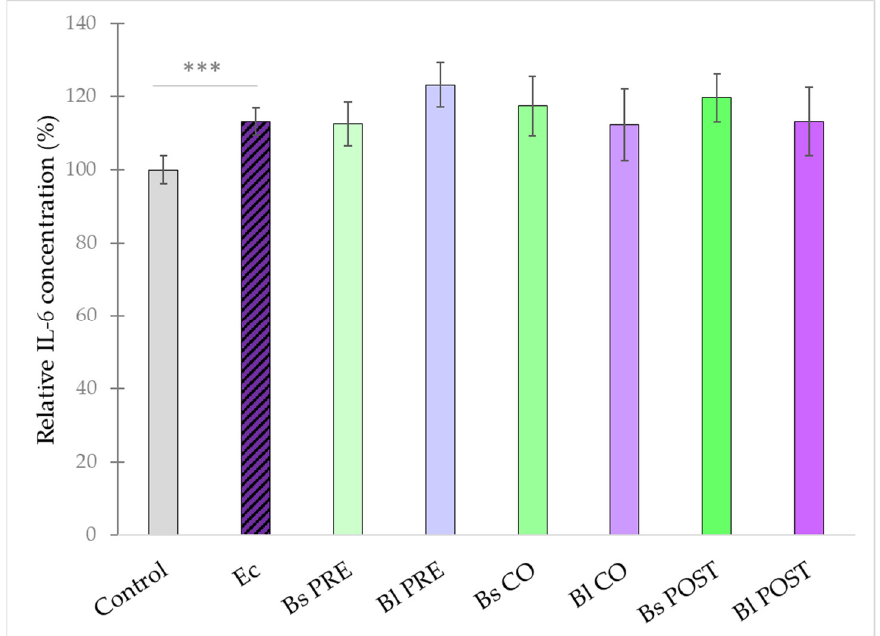
Figure 6. Induction of IL-6 secretion of IPEC-J2 cells after stimulation with E. coli , B. licheniformis, and B. subtilis . B. licheniformis and B. subtilis were added 1 h before (pre-treatment), at the same time as (co-treatment), or 1 h after (post-treatment) the addition of E. coli . B. licheniformis and B. subtilis were added in 10 8 CFU/mL and E. coli was added in 10 6 CFU/mL concentration. Control : plain cell culture medium treatment; Ec : E. coli 10 6 CFU/mL; Bs PRE : pre-treatment with B. subtilis 10 8 CFU/mL + E. coli 10 6 CFU/mL; Bl PRE : pre-treatment with B. licheniformis 10 8 CFU/mL + E. coli 10 6 CFU/mL; Bs CO : co-treatment with B. subtilis 10 8 CFU/mL + E. coli 10 6 CFU/mL; Bl CO : co-treatment with B. licheniformis 10 8 CFU/mL + E. coli 10 6 CFU/mL; Bs POST : post-treatment with B. subtilis 10 8 CFU/mL + E. coli 10 6 CFU/mL; Bl POST : post-treatment with B. licheniformis 10 8 CFU/mL + E. coli 10 6 CFU/mL. Data are shown as means with standard deviations and expressed as relative IL-6 concentration, considering the mean value of control as 100%. n = 6/group. Significant difference: *** p ≤ 0.0001 in grey: compared with the untreated control. 7), and pre-treatment with B. licheniformis 10 8 CFU/mL further increased the secretion of IL-8. Pre-treatment with B. subtilis and co- and post-treatments with both probiotic bacte- ria failed to cause any significant effect on IL-8 secretion.